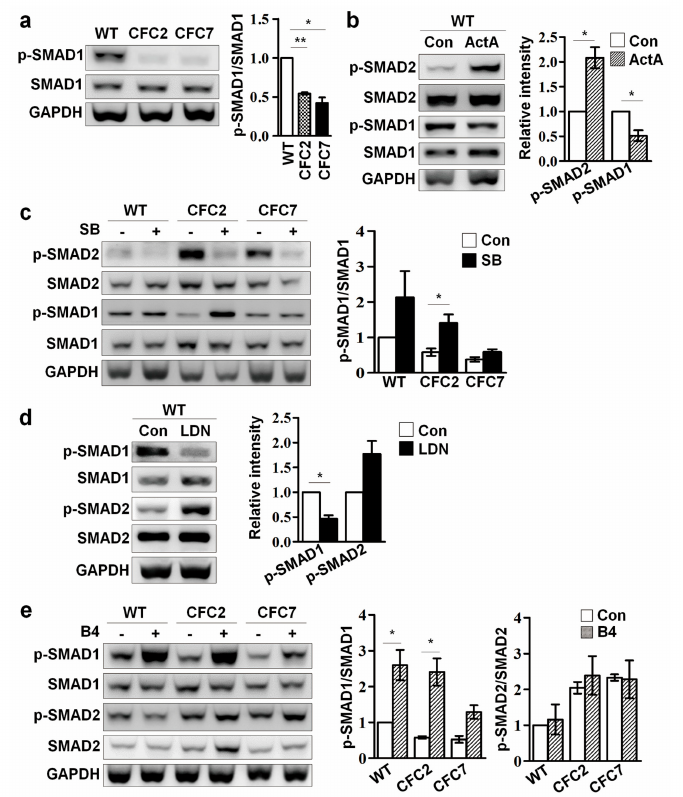
Figure 4. Correlation of SMAD2 and SMAD1 pathways in CFC-MSCs during osteogenic differentiation. ( a ) Reduced level of p-SMAD1 in CFC-Obs compared to WT-Obs; ( b ) Downregulation of the SMAD1 pathway in WT-MSCs during osteogenic differentiation by activation of the SMAD2 pathway. Treatment with ActA (50 ng/mL) significantly reduced the p-SMAD1 level in WT-MSCs during osteogenesis; ( c ) Upregulation of the SMAD1 pathway by SMAD2 pathway inhibition in CFC-MSCs during osteogenic differentiation. Treatment with a SMAD2 pathway inhibitor (SB; 5 µ M) increased p-SMAD1 level in CFC-MSCs during osteogenesis; ( d ) Effects of SMAD1 pathway inhibition in CFC-MSCs during osteogenesis. Treatment with LDN (a SMAD1 pathway receptor inhibitor, 100 nM) enhanced the p-SMAD2 level in WT-MSCs during osteogenic differentiation; ( e ) Change in the SMAD2 pathway by a SMAD1 pathway agonist (B4). Treatment with B4 (50 ng/mL) elevated the p-SMAD1 level but did not change the p-SMAD2 level in WT- and CFC-MSCs during osteogenic differentiation. Data were expressed as the mean ± SEM (n = 3, biological replicate). * p < 0.05, ** p <